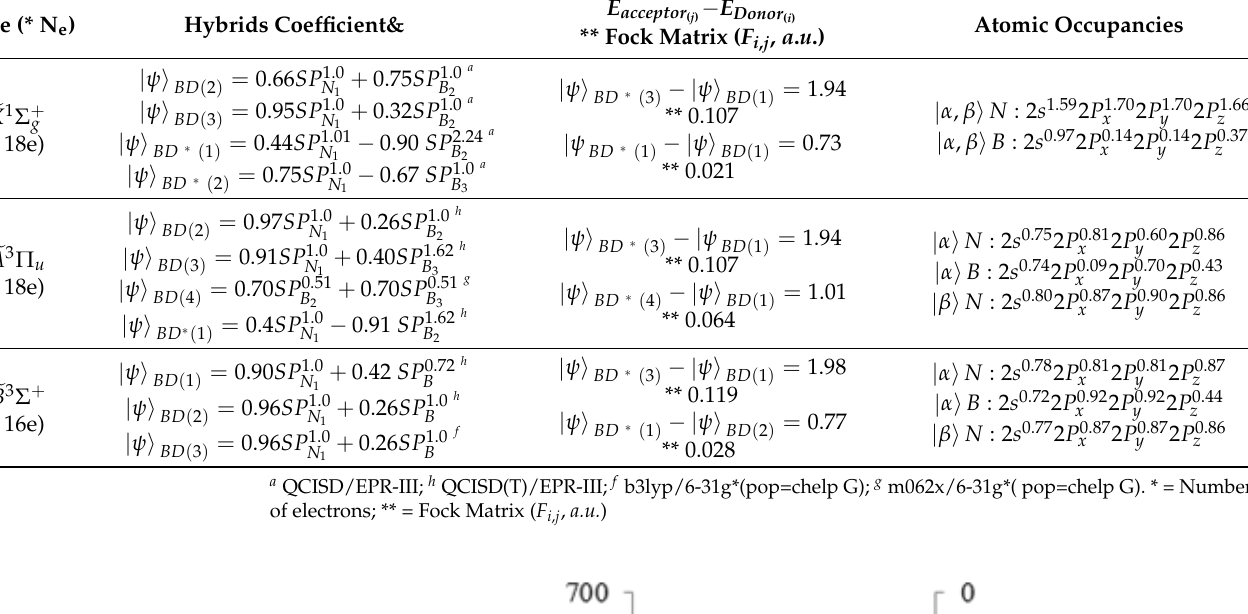
Table 4. The NBO, electric potential, anisotropic spin dipole couplings (ASDF), isotropic Fermi contact coupling { 𝐼𝐹𝐶𝐶[𝑓(∆)] , 𝐼𝐹𝐶𝐶[𝑓(𝜃)] }, atomic occupancies and Fock Matrix data of isolated and non-isolated forms of B 2 𝑁 (−,0,+) in ground and excited states.